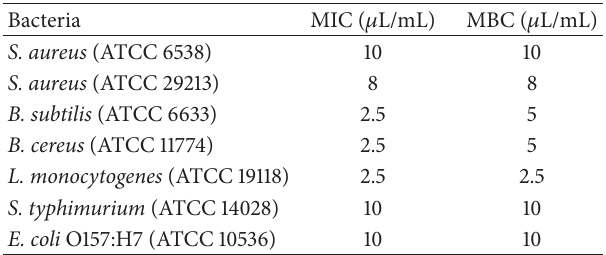
Table 2: Antibacterial activity of M. spicata essential oil indicated as